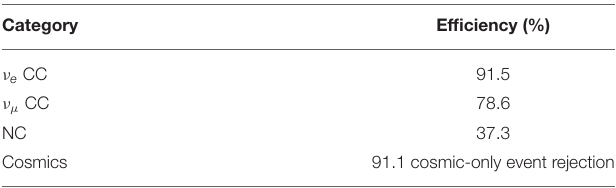
TABLE 3 | Selection efficiencies for sample cuts using the inference output of the best